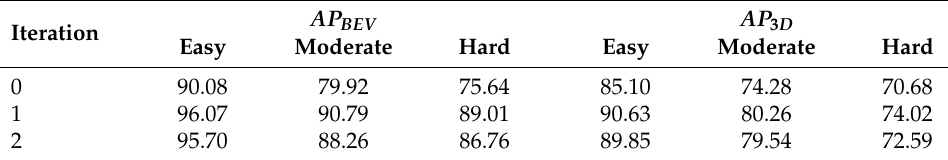
Table 4. The ablation study for iteration number on car category